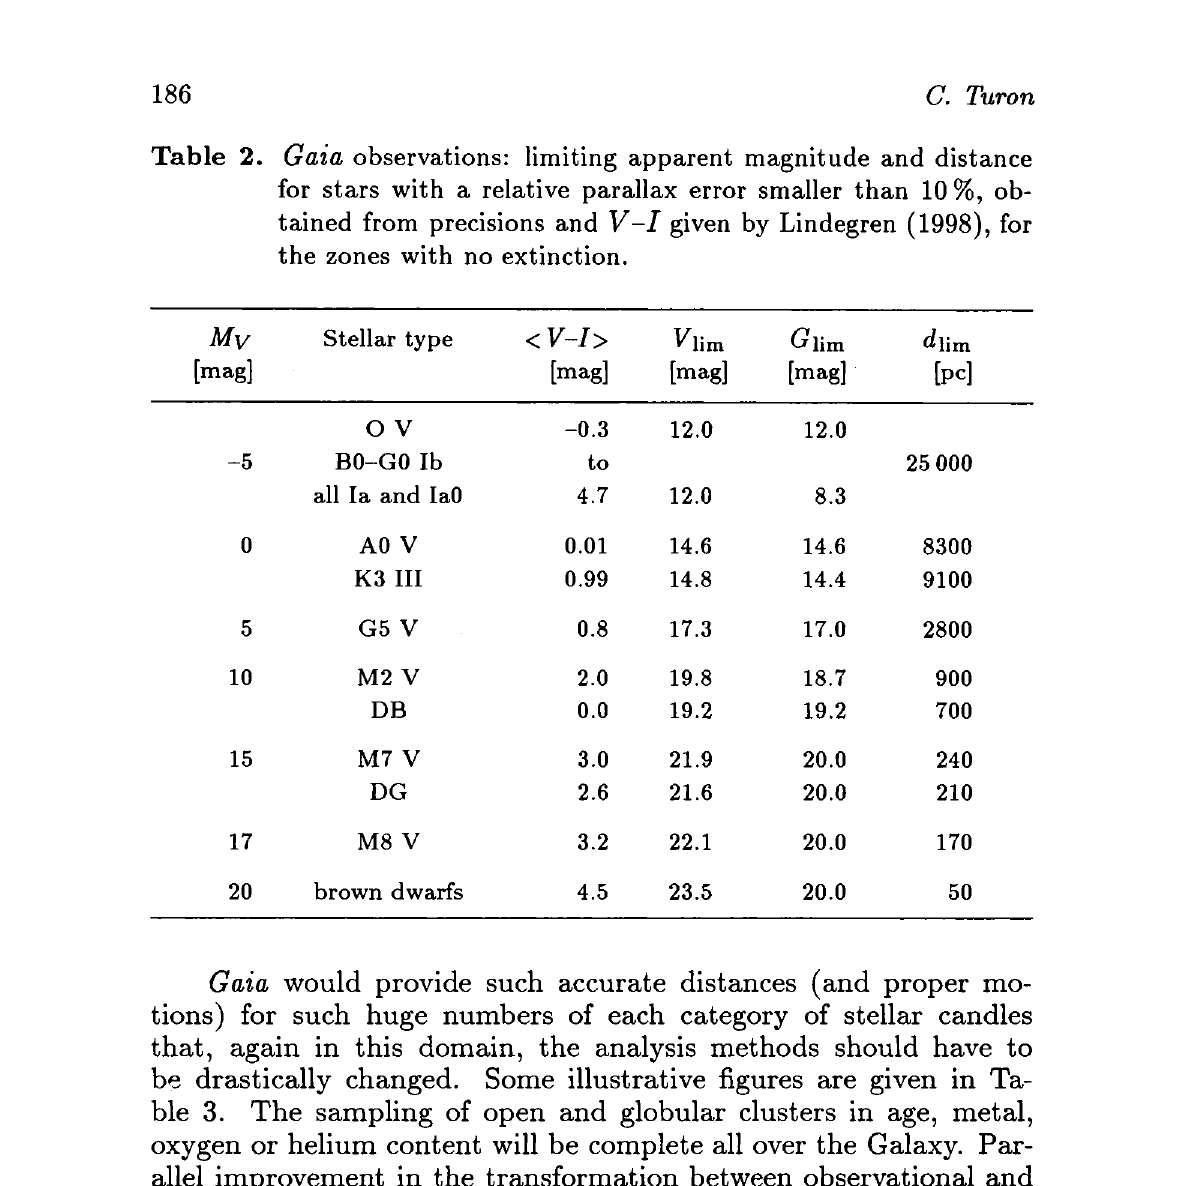
Table 2. Gaia observations: limiting apparent magnitude and distance for stars with a relative parallax error smaller than 10 %, ob- tained from precisions and V -I given by Lindegren (1998), for the zones with no